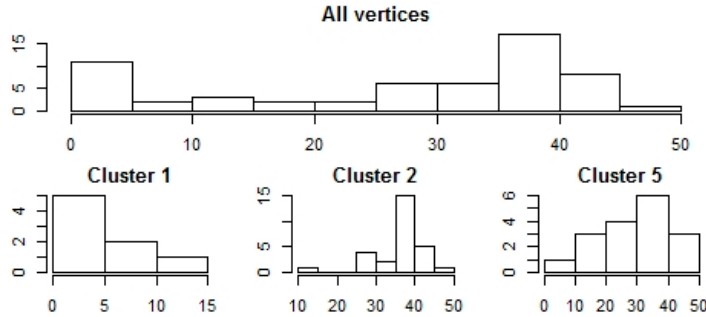
Figure 13. Histogram of vertex count-weights, five Gaussian cluster, two nodes are connected if their similarity is stronger than 0.2.